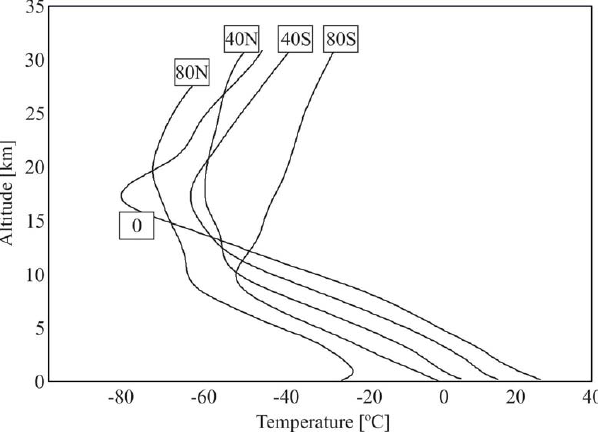
Fig. 8. Low, middle and high latitude mean temperature profiles from NCEP reanalyses zonally averaged during January 2007.